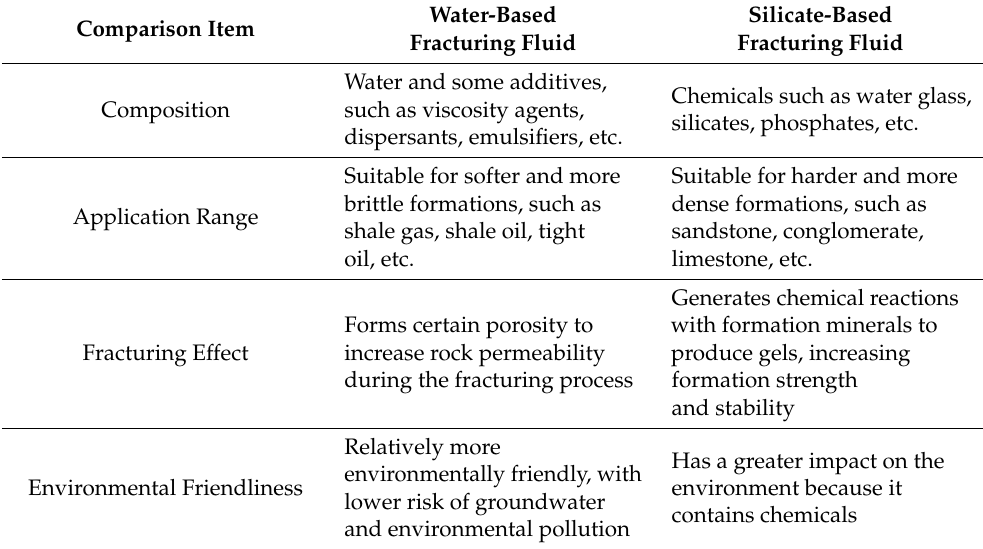
Table 2. The differences between water-based and silicate fracturing